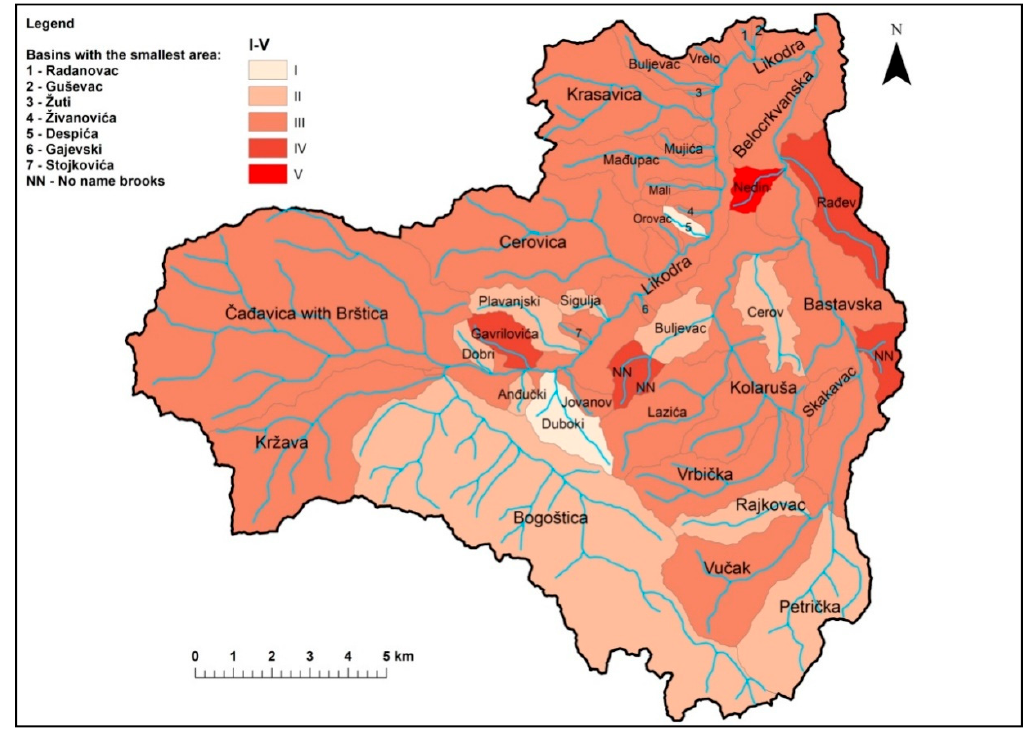
Figure 4. Intensity erosion categories in the Likodra river basin.